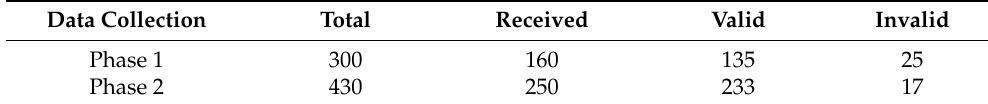
Table 1. Total questionnaires sent and their turnover.